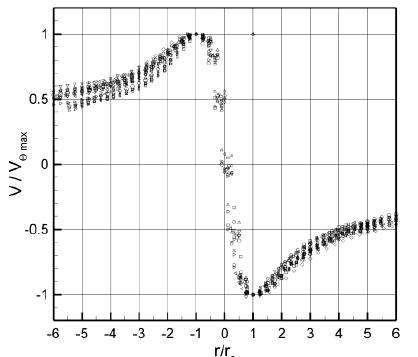
Fig. 7 Normalized tangential velocity induced by the tip